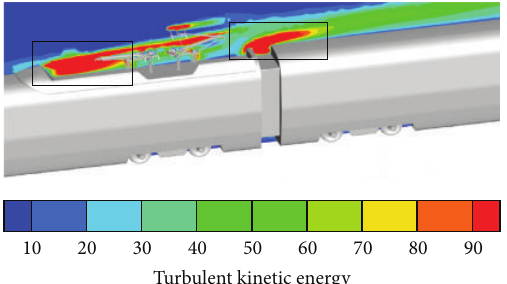
Figure 8: TKE distribution in the pantograph fairing region.